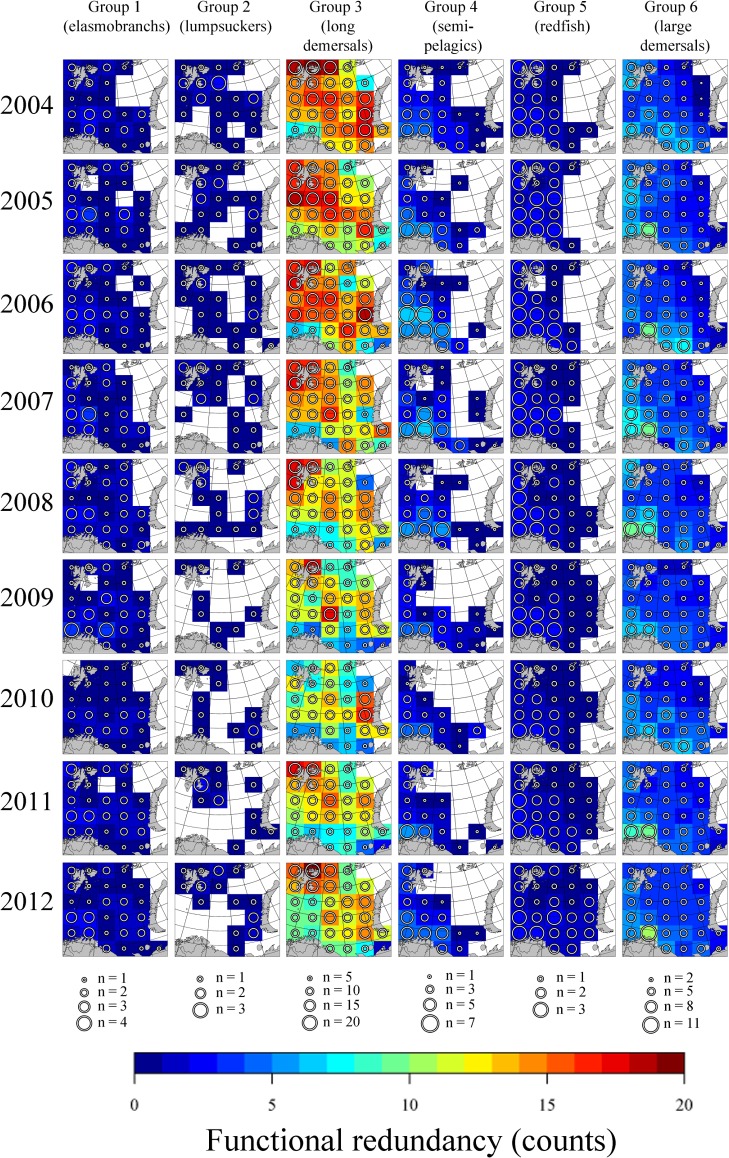
Functional redundancy of demersal fish in the Barents Sea in the period 2004–2012, presented by colour scale and circle size.For each grid cell, functional redundancy was measured as the number of species present per functional group. Circle size varies between the functional groups.